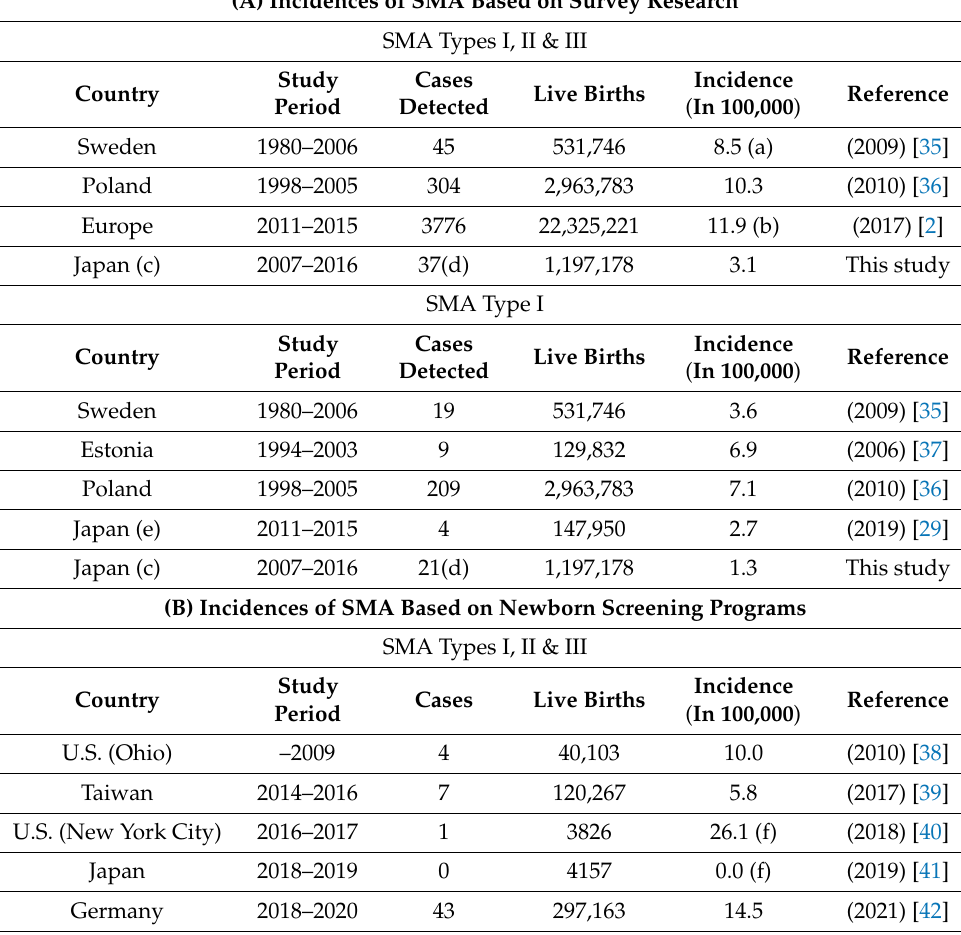
Table 5. Incidence of SMA in various